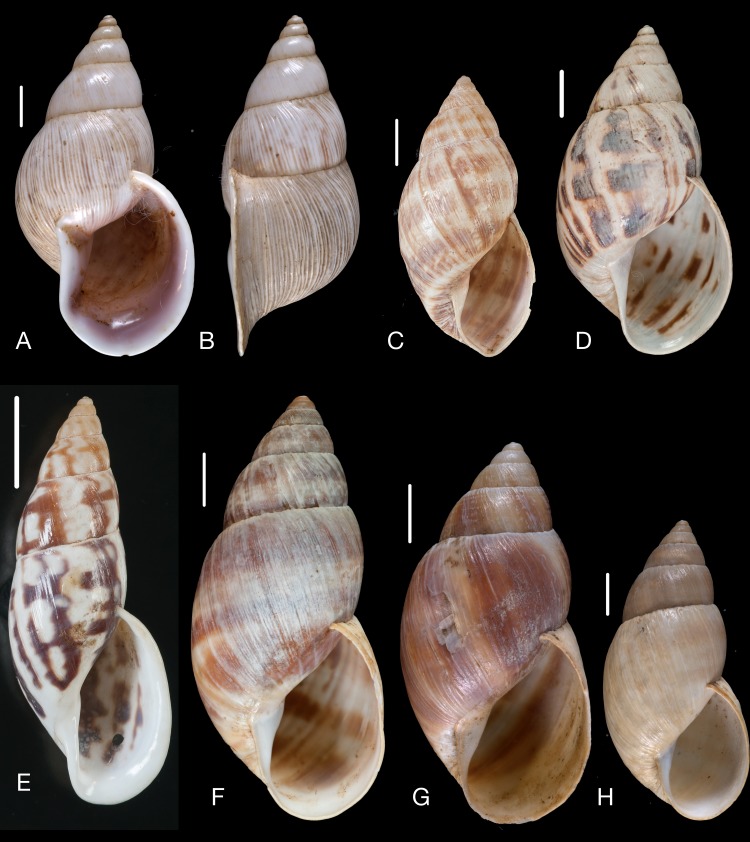
Material collected by the CCP.(A–H) Bulimulidae. Drymaeus (Drymaeus) expansus (Pfeiffer, 1848), MNCN 15.05/13480, (A) ventral view, (B) lateral view (lip); Drymaeus (Drymaeus) nystianus (Pfeiffer, 1853), MNCN 15.05/7331, (C) ventral view; Drymaeus (Drymaeus) papyraceus (Mawe, 1823), MNCN 15.05/13672, (D) ventral view; Drymaeus (Drymaeus) inaequalis (Pfeiffer, 1857), MNCN 15.05/7210, (E) ventral view; Kuschelenia (Bocourtia) aequatorius (Pfeiffer, 1853), MNCN 15.05/76211, (F) ventral view; Kuschelenia (Bocourtia) caliginosus (Reeve, 1849, MNCN 15.05/21231, (G) ventral view; Kuschelenia (Bocourtia) cf. culminea (d’Orbigny, 1835), MNCN 15.05/20238, (H) ventral view. Scale line 5 mm (all except E), 1 cm (E).